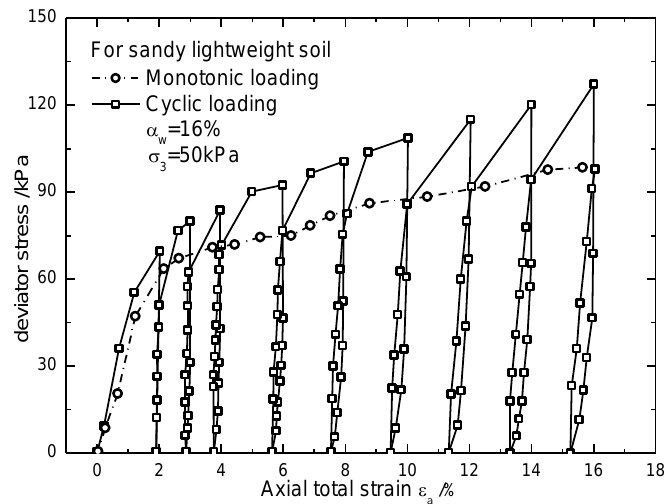
Figure 4. Typical stress-strain curve under monotonic loading and cyclic loading.